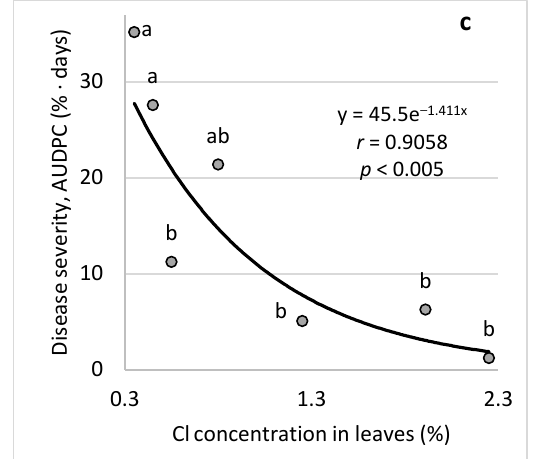
Figure 8. Relations of Na and Cl concentrations in leaves and cucumber downy mildew (CDM, Pseudoperonospora cubensis ) following spraying of NaCl solutions. Relationship between NaCl con- centration in the irrigation water and the ions concentration in leaves ( a ), and effect of leaf Na + concentration ( b ) and Cl − concentration ( c ) on CDM severity. CDM severity was evaluated on a 0–100% scale, where 0% = no disease symptoms and 100% = leaf fully covered by CDM symptoms. The area under the disease progress curve (AUDPC) was calculated. Values followed by a common letter are significantly not different from each other according to Tukey-Kramer’s HSD test ( p ≤ 0.05). The regression formulas of the drawn trend lines are presented, and the correlation Pearson regression values ( r ) are presented along with significance levels ( p ).